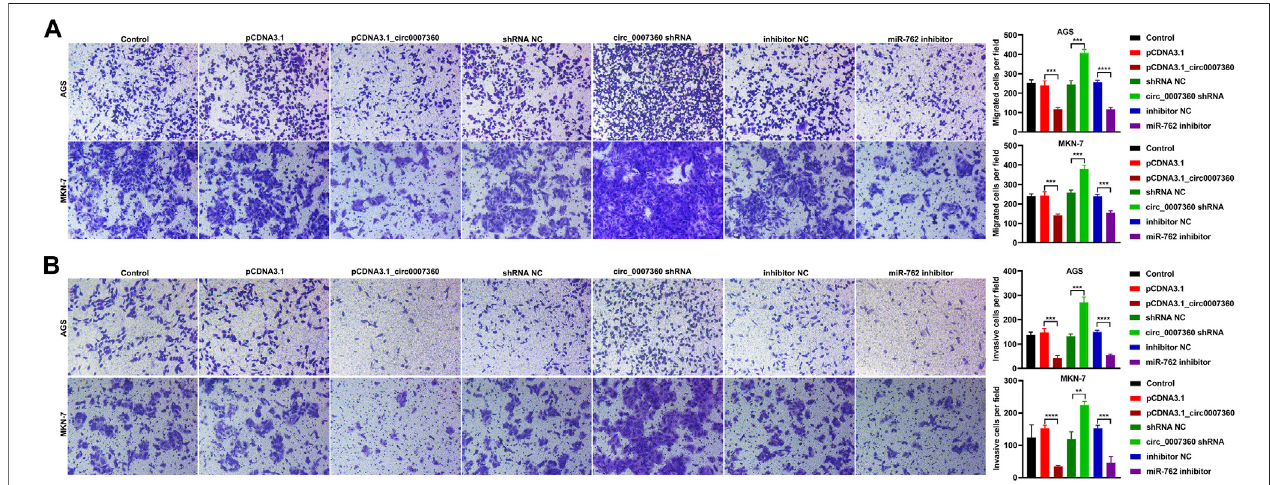
FIGURE 4 | Circ0007360 attenuates while miR-762 augments cell migration and invasion. (A , B) Representative images and quanti fi cation of transwell results for detecting the migration (A) or invasion (B) in cells with ectopic expression of circ0007360 , knockdown of circ0007360, or miR-762 .